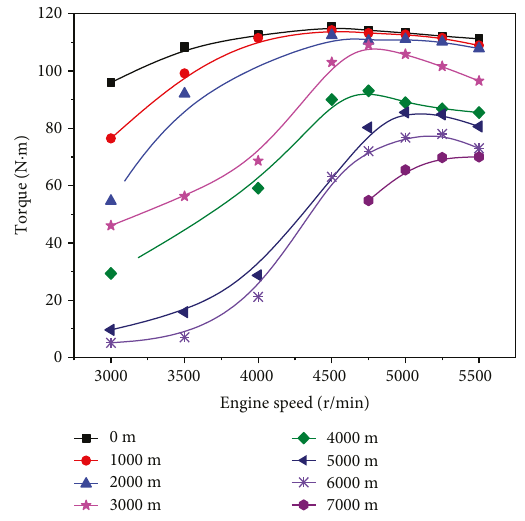
Figure 8: Output torque curves at di ff erent